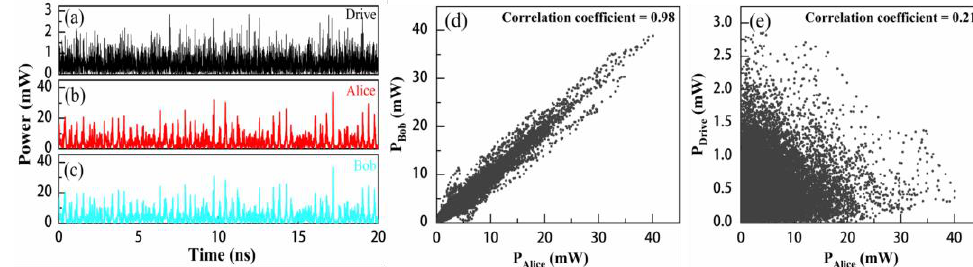
Figure 3. Time series of ( a ) drive signal, ( b ) DFB a , and ( c ) DFB b ; ( d ) correlation plots of the trans- ceiver; ( e ) correlation plots of DFB a and drive signal. ( e ) correlation plots of DFB a and drive